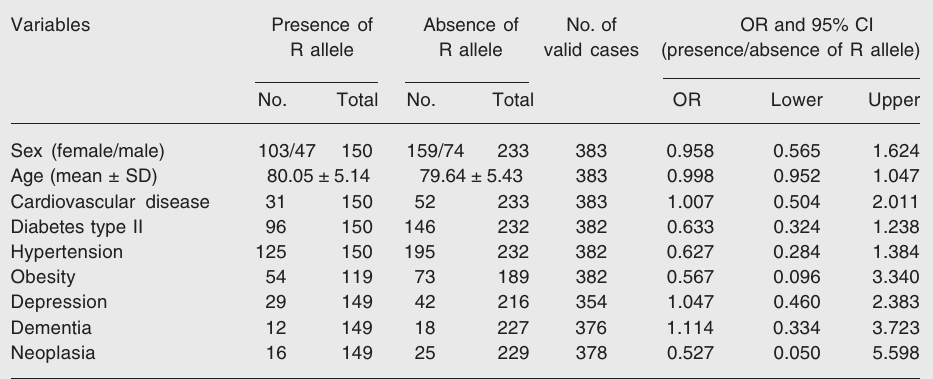
Table 2. Number of subjects with the presence or absence of the R allele in relation to sex, age and morbidity and results of logistic regression analysis. Variables